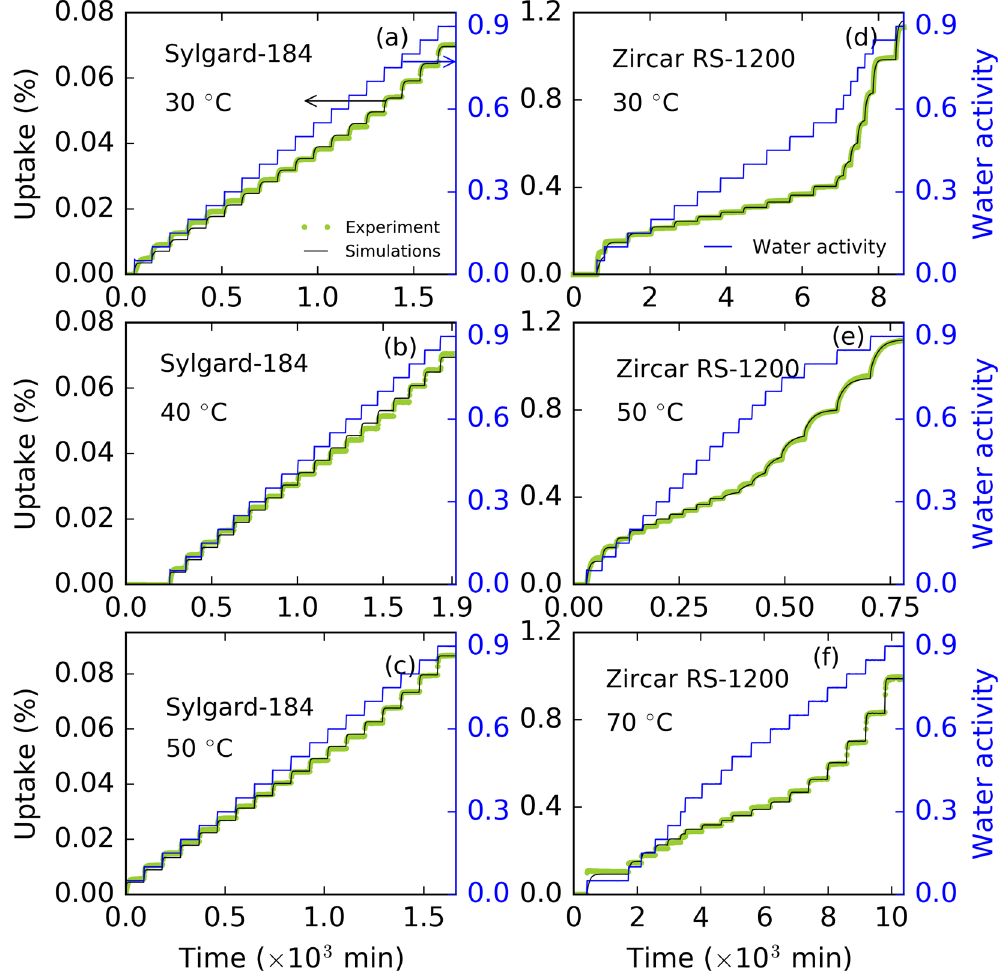
Figure 3. Comparison of the optimized triple-mode sorption-diffusion model against moisture sorption experiments with Sylgard-184 and Zircar RS-1200. Panels (a–c) model performance for Sylgard-184 for uptake (%) vs time (minutes) with water activity in right y-axis at 30 °C, 40 °C, and 50 °C. Panels (d–f) model performance for Zircar RS-1200 for uptake (%) vs time (minutes) with water activity in right y-axis at 30 °C, 50 °C, and 70 °C. Yellow-green symbols, black lines, and blue lines represent the experimental moisture uptake data (on left y-axis), model simulations (on left y-axis), and experimental water activity (on right y-axis),